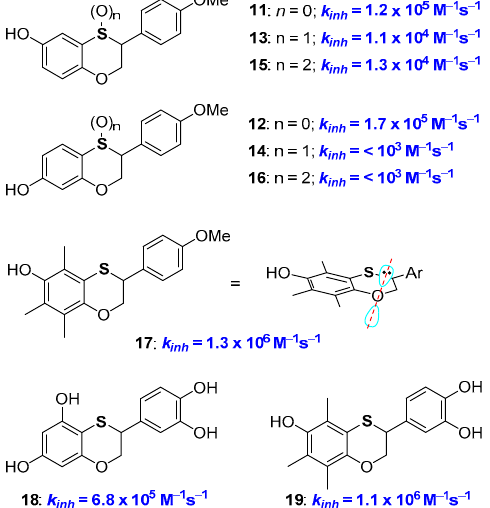
Figure 6. A selection of 2,3-dihydrobenzo[1,4]oxathiine multi-defence antioxidants.